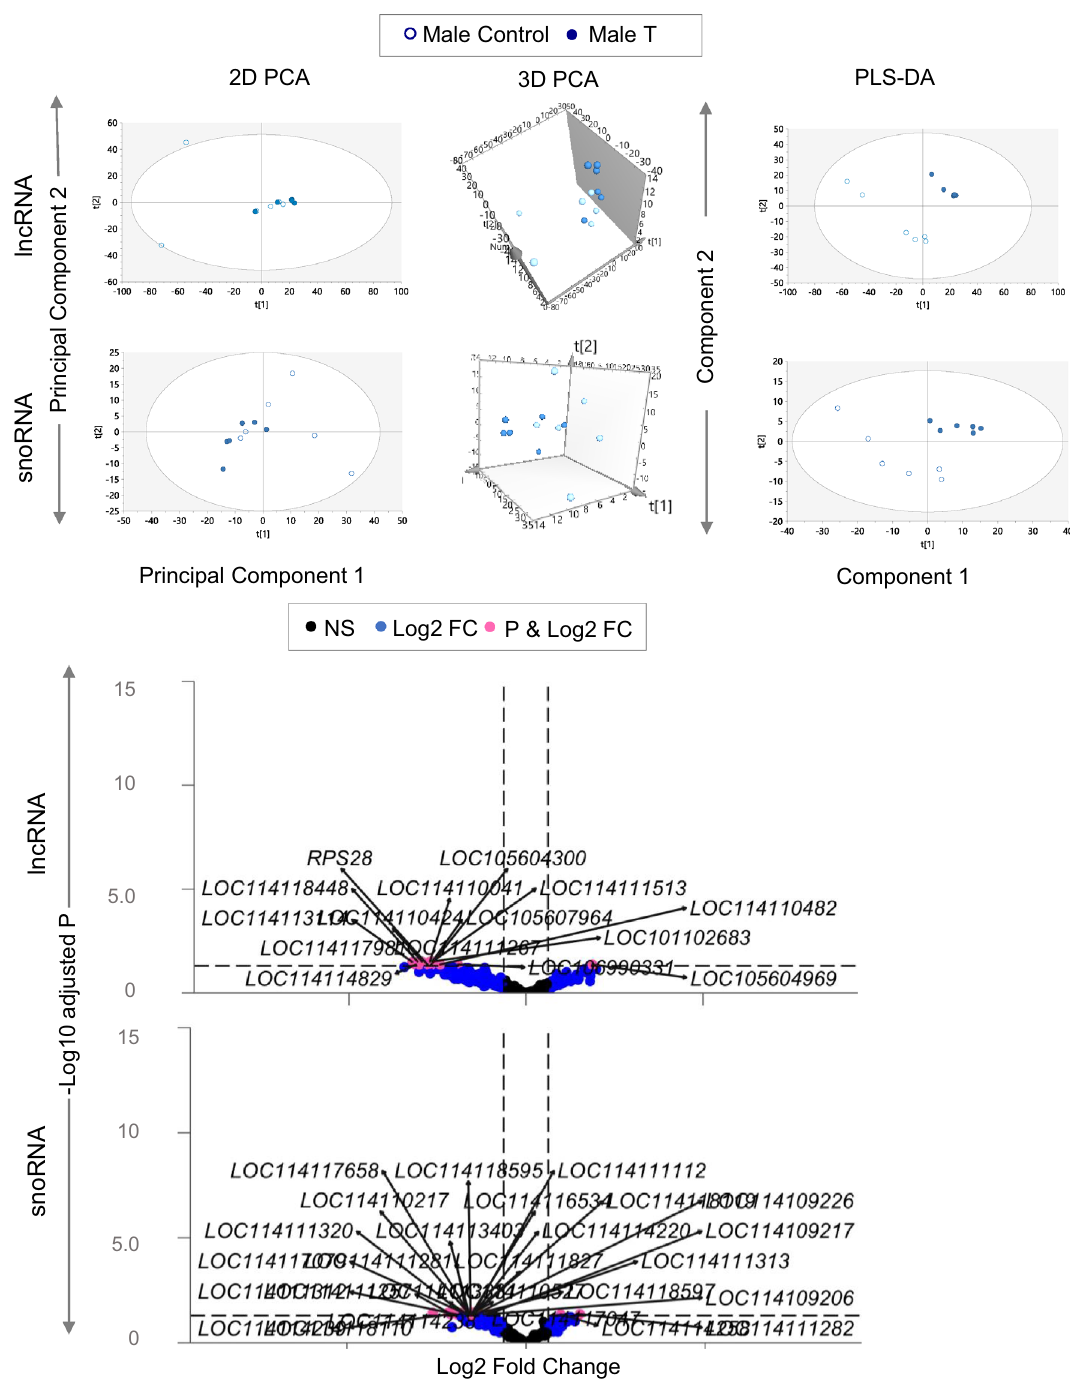
Figure 7. Long non-coding and Small nucleolar RNA Clustering and Differential Expression in males: The 2D, 3D PCA plots and PLS-DA showing clustering between control (blue open circle for male) and prenatal T-treated fetal cardiac tissue (blue closed circle for male) groups in the lncRNA and snoRNA from fetal cardiac tissue are shown on the top. For the PCA the 2D plots, 3D plots are plotted with principal component 1 on X-axis and principal component 2 on Y-axis, and PLS-DA plots are plotted with component 1 in the X-axis and component 2 on the Y-axis, with each point representing one animal. Volcano plots showing differential lncRNA and snoRNA expression in the male cardiac tissues of prenatal T-treated animals compared against the control animals are shown on the bottom. The log2 fold change values are represented against the X-axis and − log10 adjusted p -values are represented along the Y-axis. Pink dots represent those ncRNA that met absolute log2FC > 0.5 and p-adjusted cut-off of < 0.05. Black dots represent ncRNA genes that did not meet either p-adjusted cut-off of < 0.05 or absolute log2FC > 0.5 and blue dots represent genes which met absolute log2 fold change > 0.5 but did not meet the adjusted p -values <